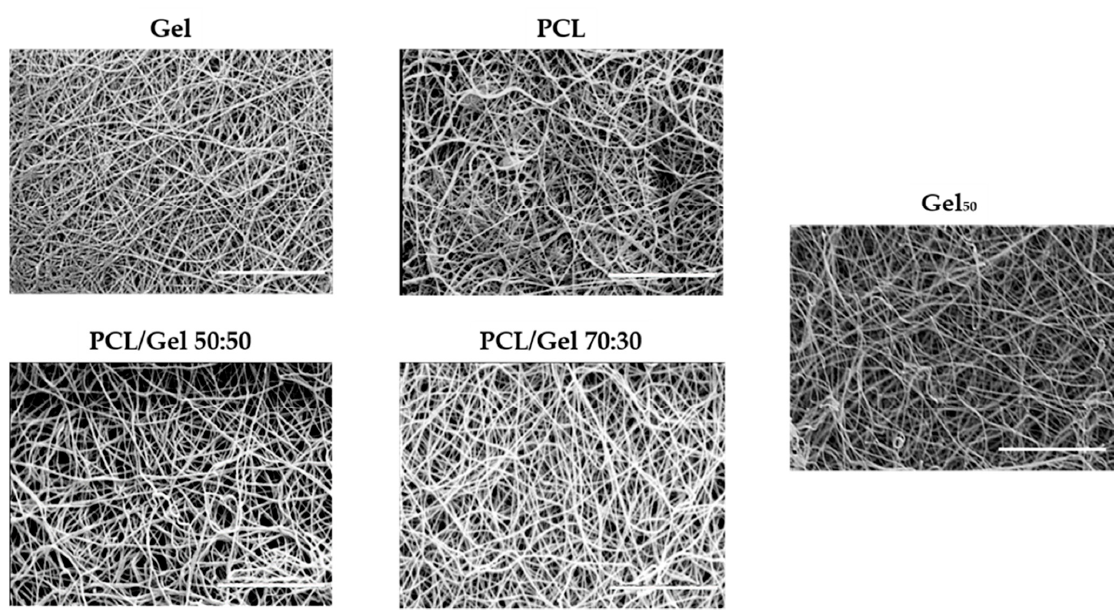
Figure 3. SEM images of NGC guides. Scale bar: 10 µm.